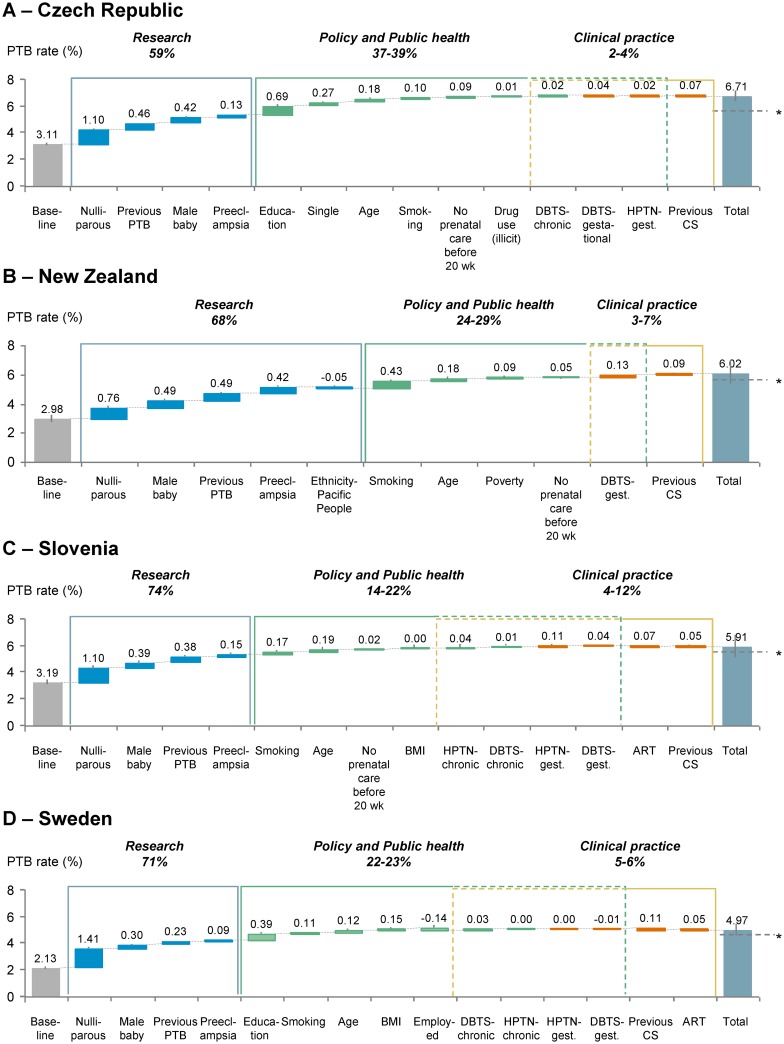
Estimated contribution of risk factors on population preterm birth rate and opportunities for various stratified interventions for (A) Czech Republic, (B) New Zealand, (C) Slovenia, (D) Sweden.Results from the logistic regression analysis were combined with prevalence of risk factor to estimate the impact of each risk factor (see Methods). Risk factors were grouped into three intervention areas, "Research", "Policy and Public Health", "Clinical Practice". Some risk factors (e.g. diabetes, hypertension) could and were classified into multiple categories. Percentage ranges indicated for "Policy and Public Health" and "Clinical Practice" thus reflect scenarios with or without inclusion of these overlapping risk factors. An asterisk represents the observed preterm birth rate in each dataset. Error bars: 95% confidence intervals. Abbreviations: PTB, preterm birth; HPTN, hypertension; DBTS, diabetes; CS, cesarean section; ART, assisted reproductive technology; 20wk, 20 weeks.